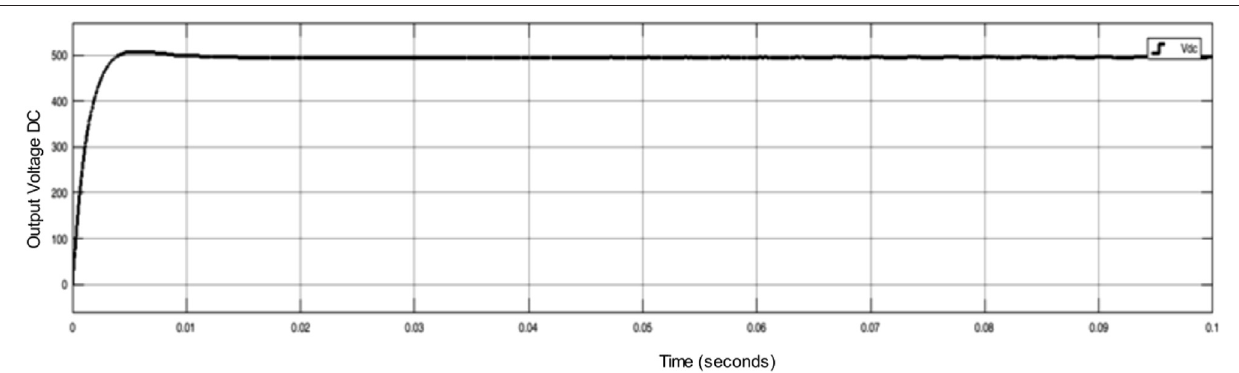
FIGURE 9 | DC output of micro-grid without